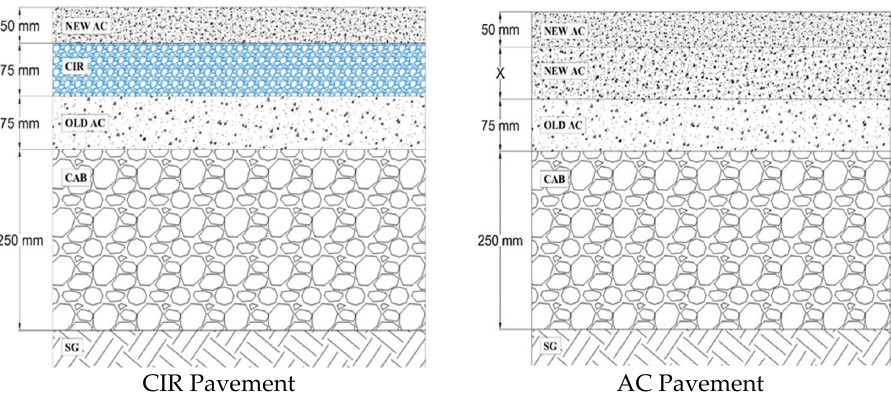
Figure 3. Flexible pavement structures using CIR and AC layers. Figure 2. Flow chart of mechanistic analysis approach.